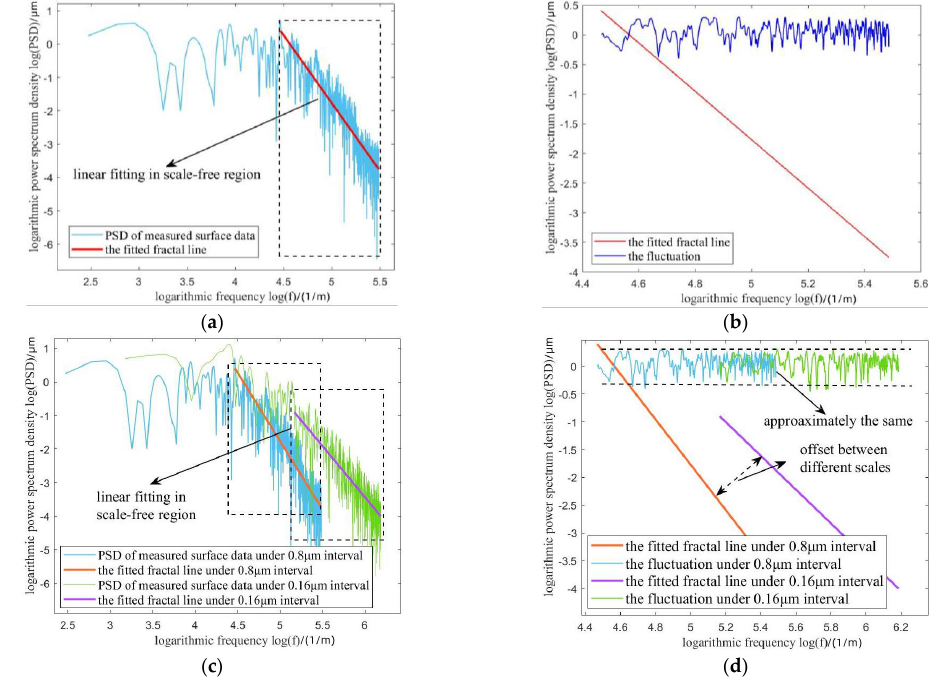
Figure 3. Separation of three components in linear log-log PSD. ( a ) linear function under a single scale; ( b ) the fractal components and fluctuation components under a single scale; ( c ) linear function under multi-scales; ( d ) the fractal components, fluctuation components, and offset components un- der multi-scales. Table 1. Detailed parameters under the two scales.